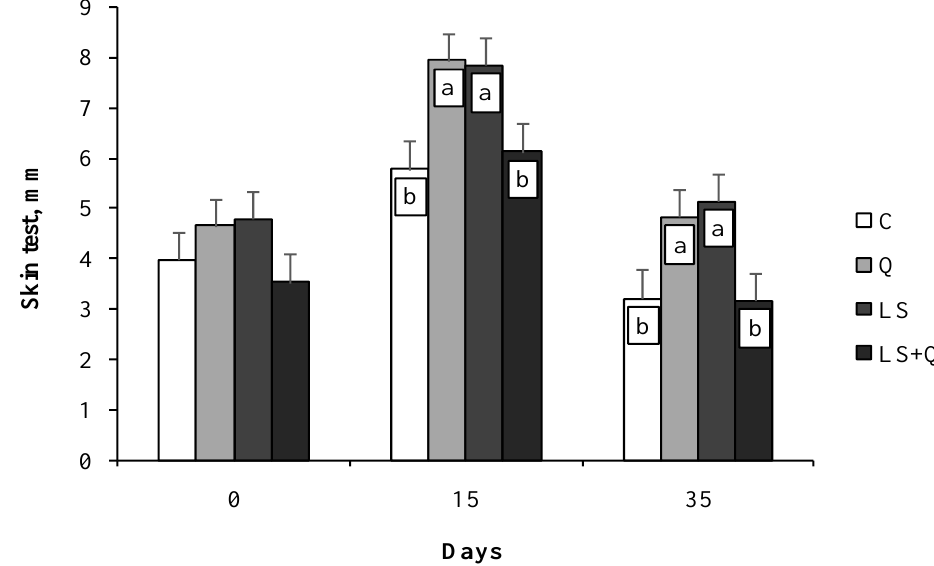
Figure 2. Skinfold thickness (Least Squares means ± SEM) measured after PHA injection at 0, 15, and 35 day of the experiment in lambs as affected by different diet supplementation (C = control; LS = linseed; Q = quinoa seed; LS + Q = linseed + quinoa). a,b different letters differ among feeding treatments within a sampling day ( p < 0.05).